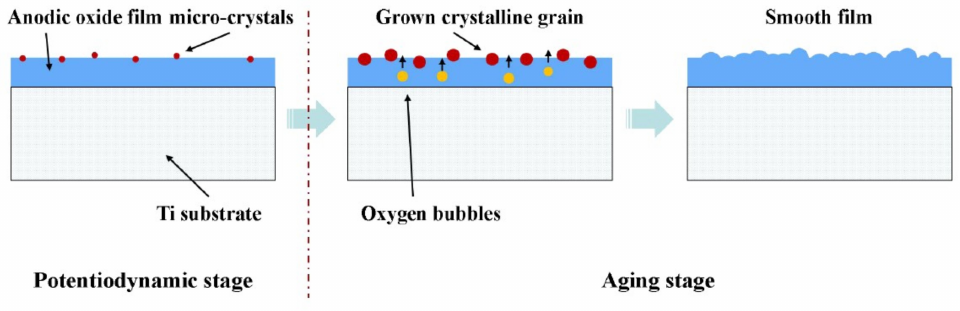
Figure 12. Schematic illustration of the crystallization process of oxide films under different